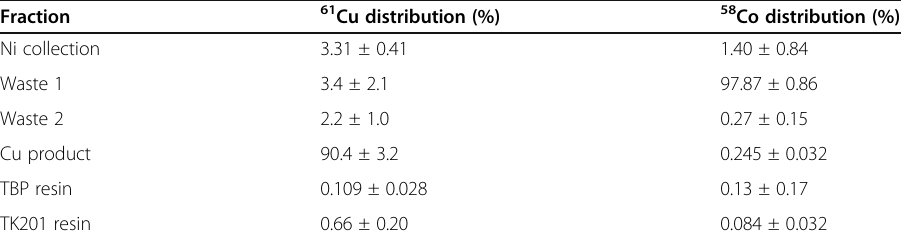
Table 4 The normalized activity distribution data of 58 Co and 61 Cu ( N = 5), which is visually represented in Fig. 2. Note that the 58 Co and 61 Cu have been normalised individually Fraction 61 Cu distribution (%) 58 Co distribution (%) Ni collection 3.31 ± 0.41